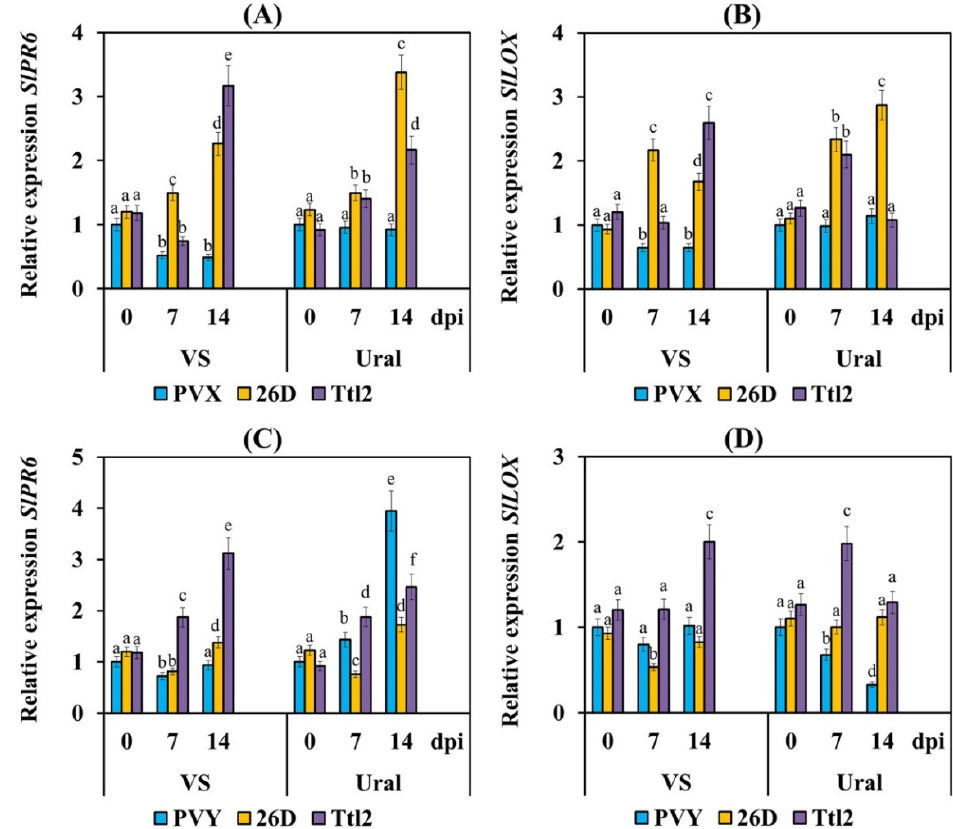
Figure 7. Influence of the endophytic strains B. subtilis 26D and B. subtilis Ttl2 on the relative expression of the JA-dependent genes SlPR6 ( A , C ) and SlLOX ( B , D ) in tomato plants of the varieties Volovye Serdtse (VS) and Ural infected with PVX ( A , B ) and PVY ( C , D ). The expression values were normalized to the housekeeping gene of tomato plants, SlACT, as an internal reference. The samples are indicated as follows: 0 dpi, control non-infected plants; PVX, plants infected with potato virus X; PVY, plants infected with potato virus Y; 26D, plants treated with B. subtilis 26D; Ttl2, plants treated with B. subtilis Ttl2. The figures present means ± SE (n = 6). The treatments marked with different Latin letters in one cultivar are statistically different from the control ones (0 dpi, not infected with viruses and not treated with bacteria) in each time-point, according to the LSD test ( p ≤ 0.05).